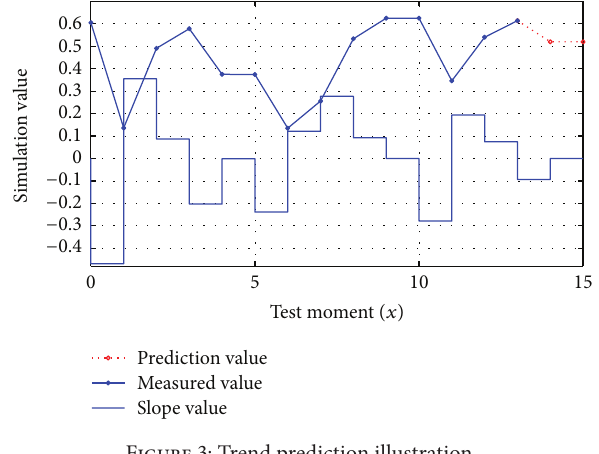
Figure 3: Trend prediction illustration.